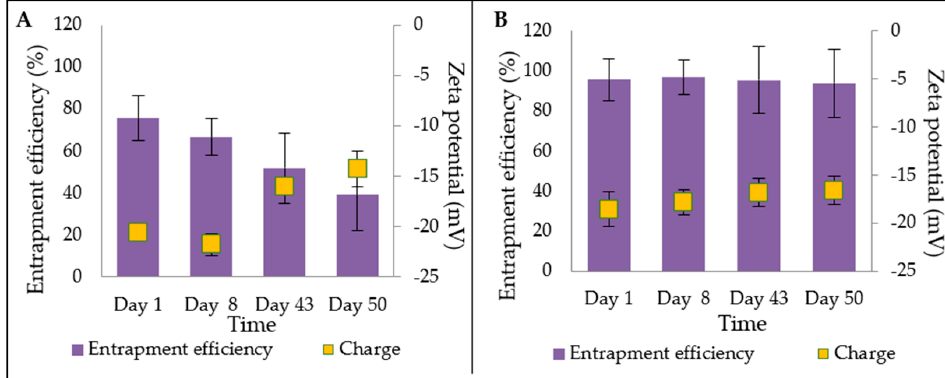
Figure 4. Stability test for entrapment efficiency over 50 days for Formulation A and B.